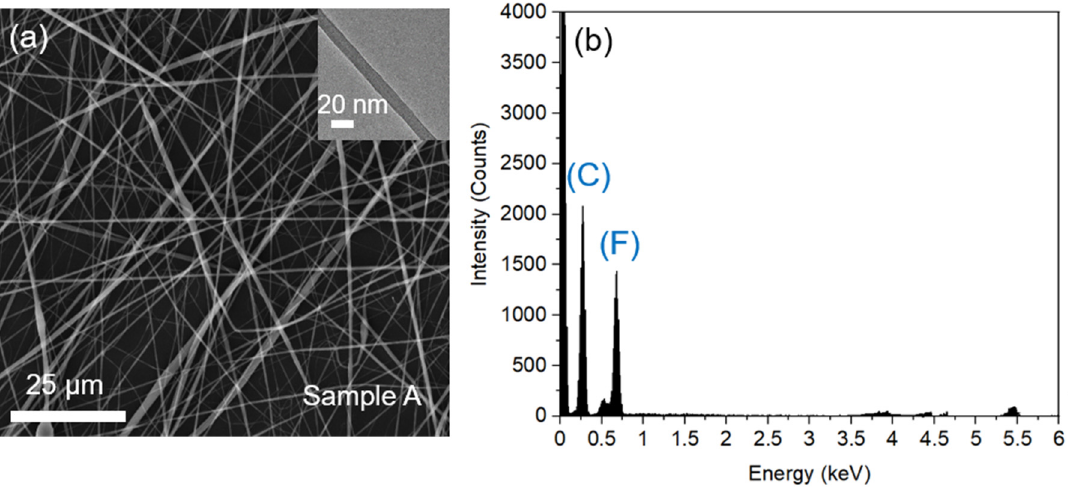
Figure 3. ( a ) SEM and TEM image of 15 wt.% electrospun PVDF fibers with the average size of 20–220 nm (standard deviation: 51.6 nm) and ( b ) EDS spectroscopy of sample A.